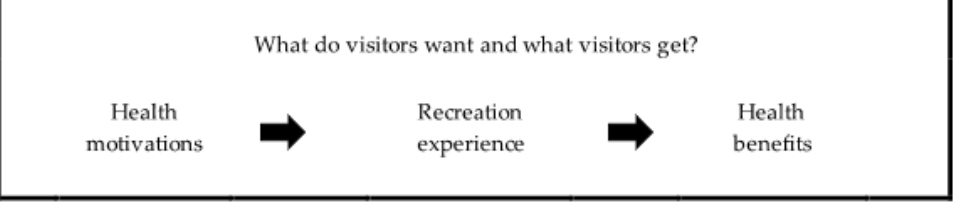
Figure 1. Simplified formulation of the motivations–benefit relationship. Adapted from [40].